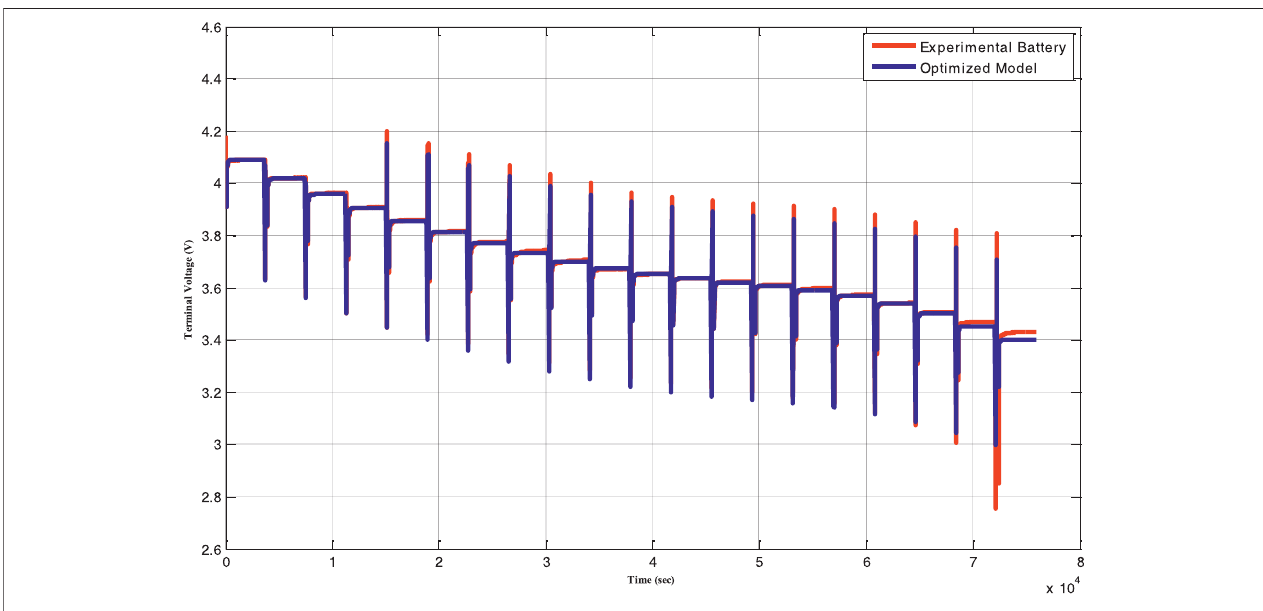
FIGURE 7 | 1RC-ECM optimized terminal voltage versus measured voltage using